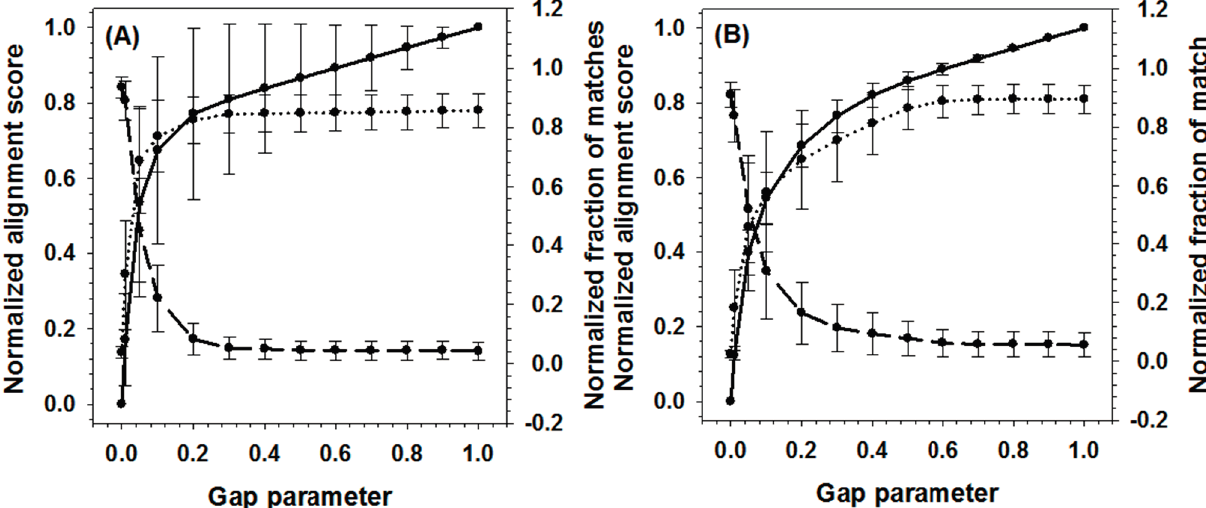
Figure 2. Influence of gap parameter on global matches for ( A ) Yeast dataset and ( B ) DisProt dataset. The solid line shows for normalized alignment score, while dash line and dotted lines represent normalized fraction of matches for two types of sequence pairs. Error